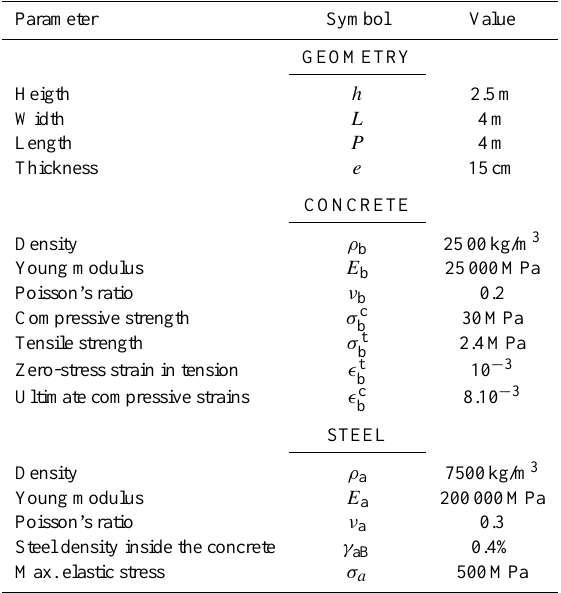
Table 1. Geometrical and mechanical features of the structure.